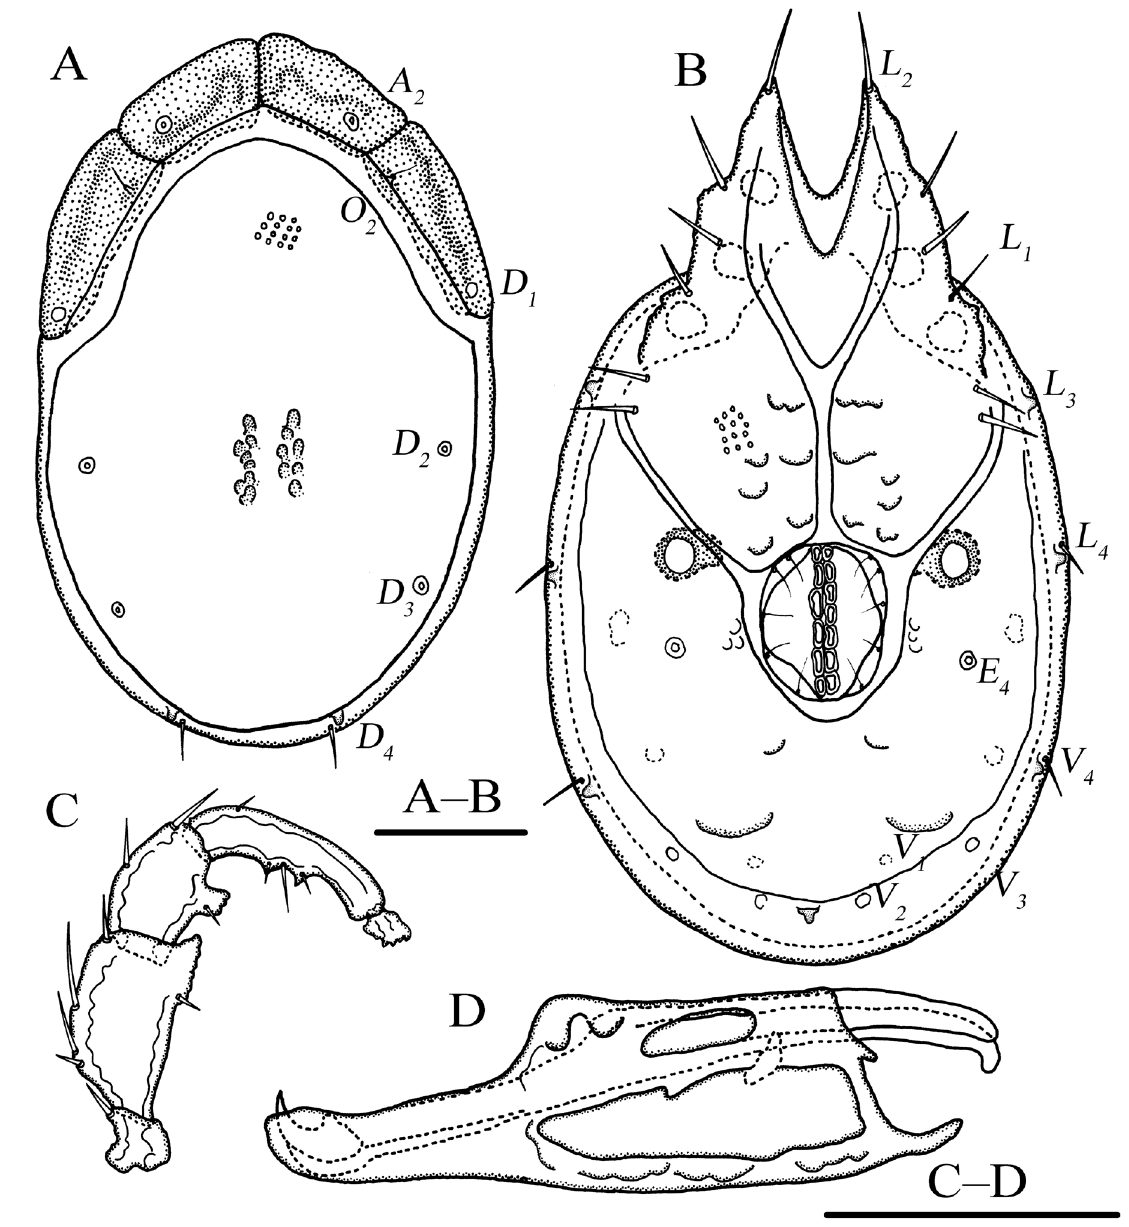
Fig. 13. Torrenticola dentifera Wiles, 1991, ♂ (FJ-TO-20180806). A . Dorsal view. B . Ventral view. C . Palp, lateral view. D . Infracapitulum and chelicera. Scale bars = 100